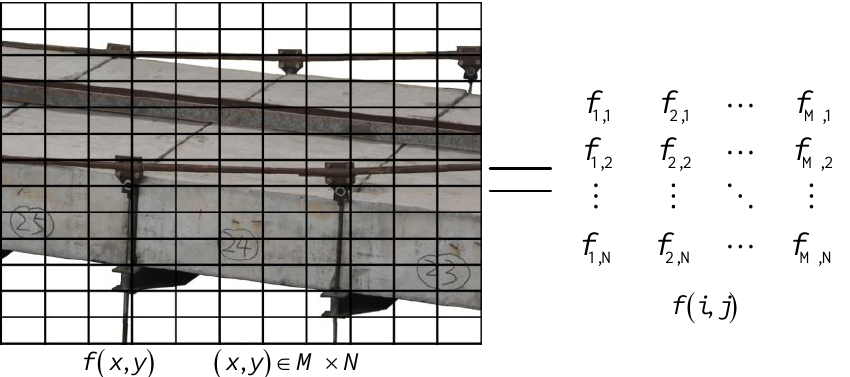
Figure 2. Matrix representation of pattern information digitalization.